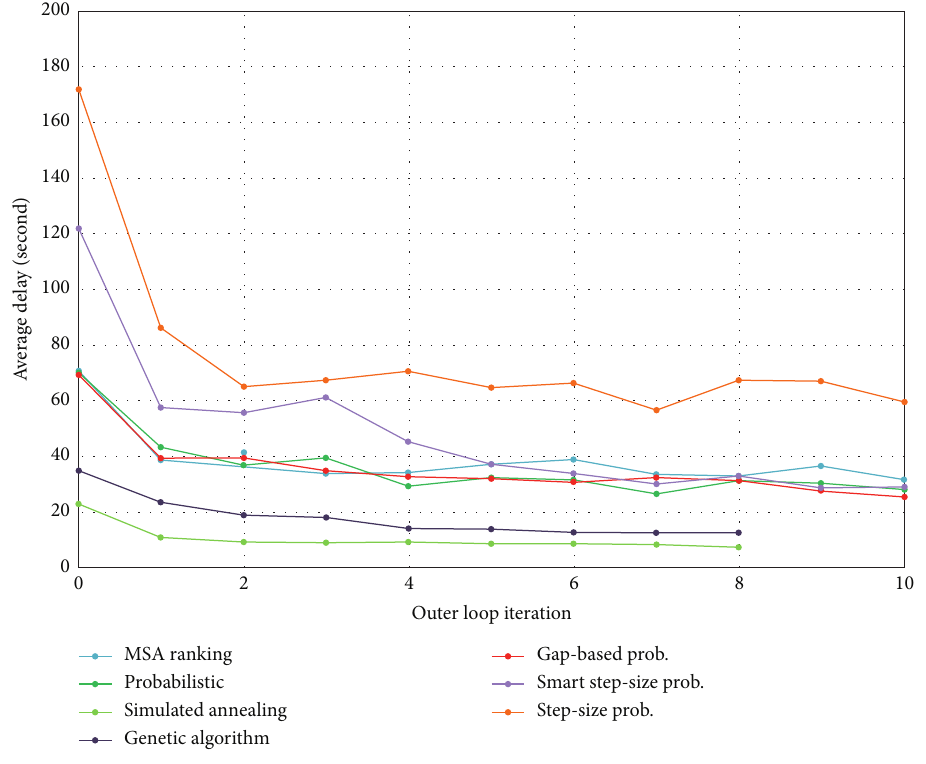
Figure 4: Convergence patterns for the outer loops. Table 4: Comparison between the performances of algorithms with homogeneous and heterogeneous